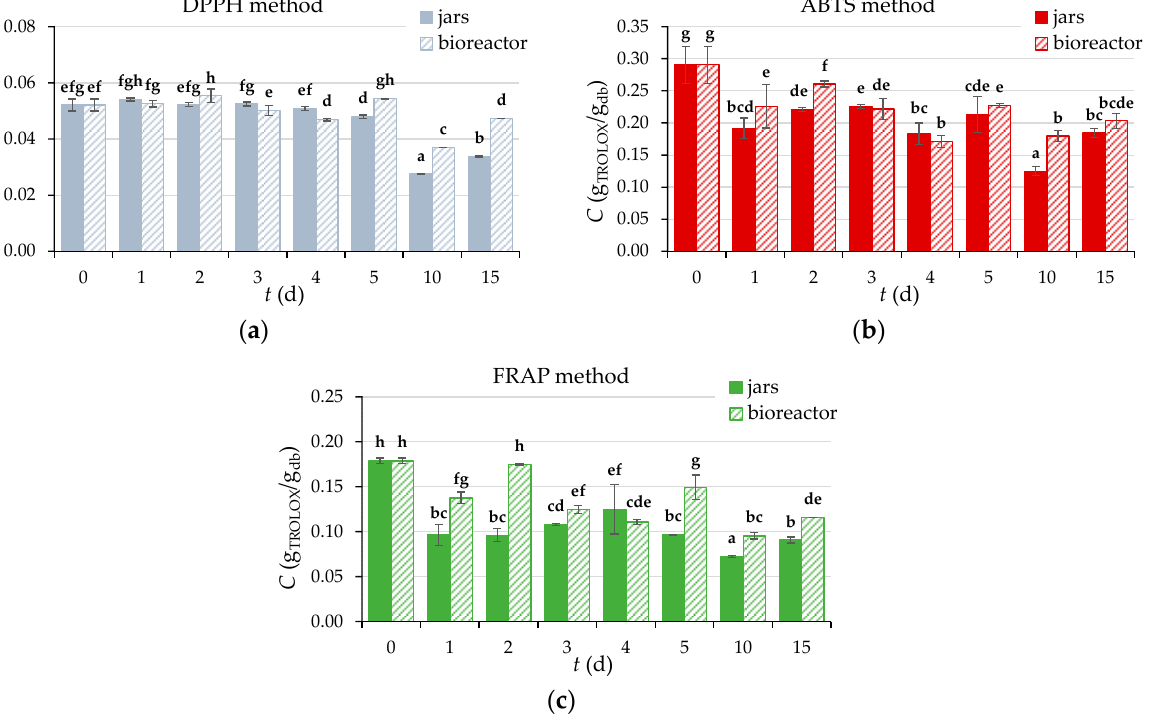
Figure 6. Antioxidant activity (DPPH method ( a ), ABTS method ( b ), FRAP method ( c )) of extracts obtained from GP before (day “0”) and after SSF (days 1–5, 10, 15) using R. oryzae in laboratory jars and tray bioreactor. Samples marked with different lowercase letters of the alphabet are statistically signi fi cantly di ff erent from each other ( p < 0.05, post-hoc Duncan multiple range test). The reason for the reduction of TPC, TF, and TPA is the enzymatic decomposition and/or polymerization of phenolic compounds released by the growth of the fungus [62].